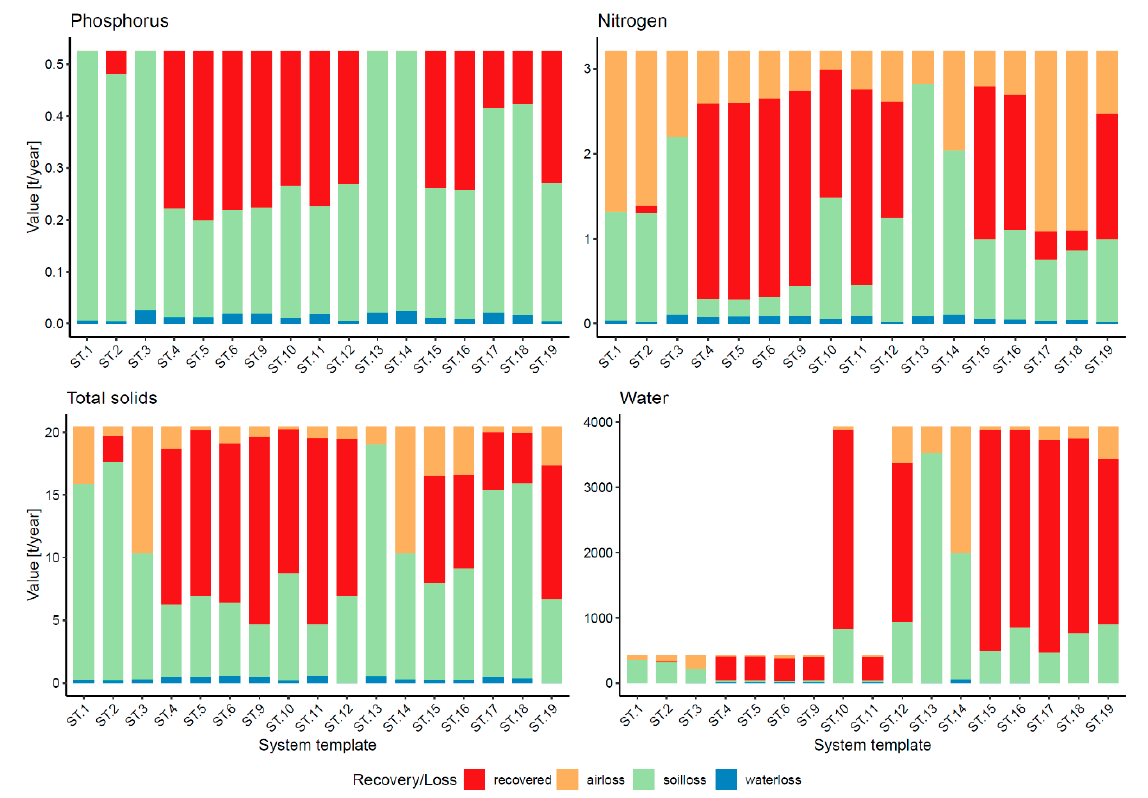
Figure 3. Stacked-bar graph of mass recovery and losses potentials for the selected systems per year.